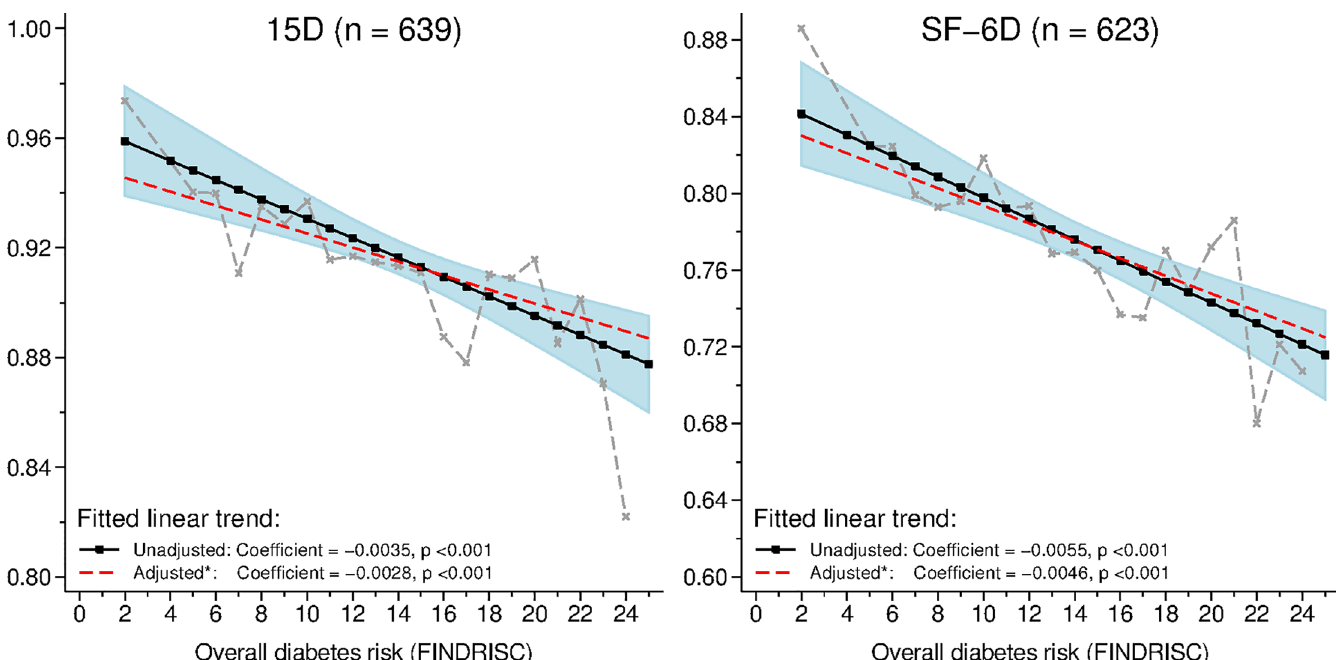
Fig 2. Observed mean HRQoL index values and fitted linear trends (95% CI) in relation to the FINDRISC scores. Linear trends were fitted to data using Tobit regression. The corresponding variance was estimated using a bootstrap procedure with 1,000 replications. * Adjusted for sex, employment and cohabiting. HRQoL: Health-related quality of life. FINDRISC: Finnish Diabetes Risk Score.